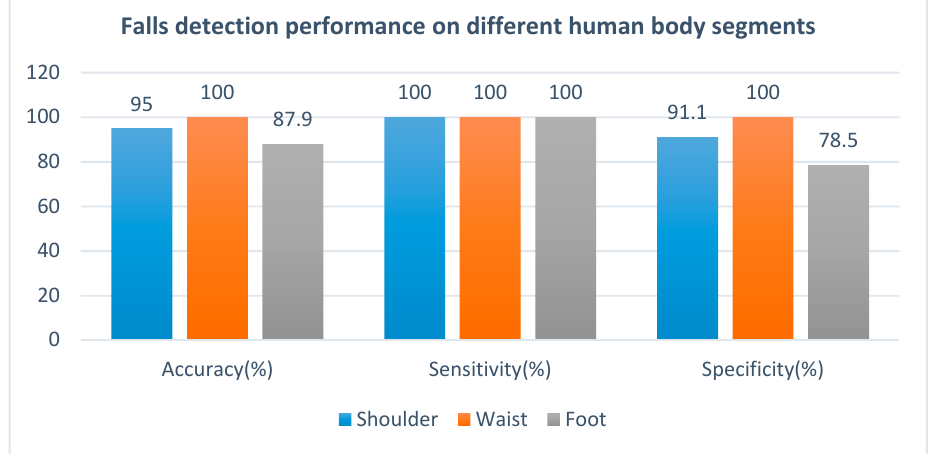
Figure 11. Fall detection performance on different human body segments.